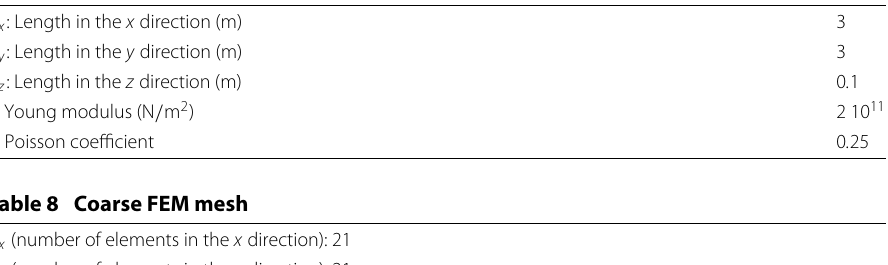
Table 7 Model parameters